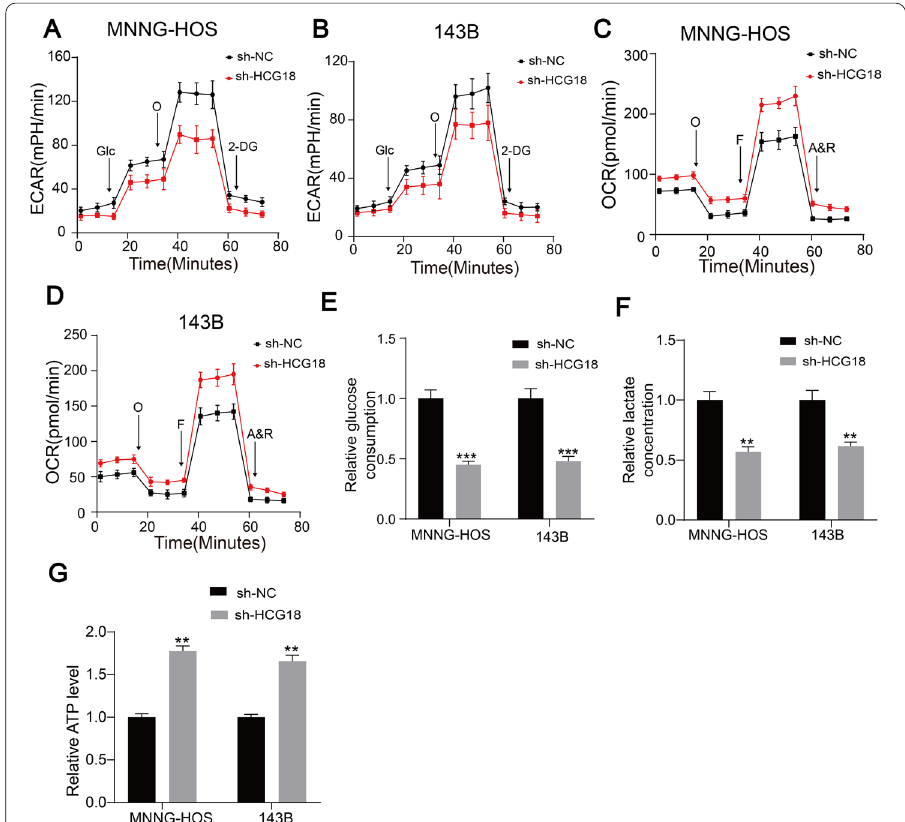
Fig. 2 HCG18 enhanced aerobic glycolysis in OS cells. A and B ECAR of sh-Control and sh-HCG18 group was detected. Glc: glucose, Oligo: oligomycin, 2-DG: 2-deoxy-d-glucose. C and D OCR of sh-Control and sh-HCG18 group was measured. O: Oligomycin, F: FCCP, A&R: antimycin A/rotenone. Glucose consumption ( E ), lactate production ( F ), and ATP level ( G ) demonstrated the effect of HCG18 knockdown on aerobic glycolysis in OS cells. ** represents P < 0.01, *** represents P < 0.001. All experiments were repeated three